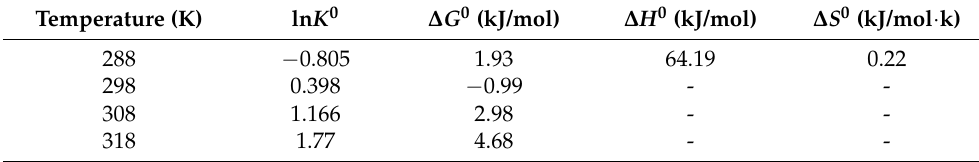
Table 1. Thermodynamic parameters for the adsorption of MB on SA/Lig-20%